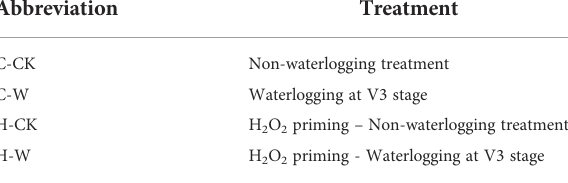
TABLE 1 Waterlogging treatments for summer maize in the fi eld from 2020 to